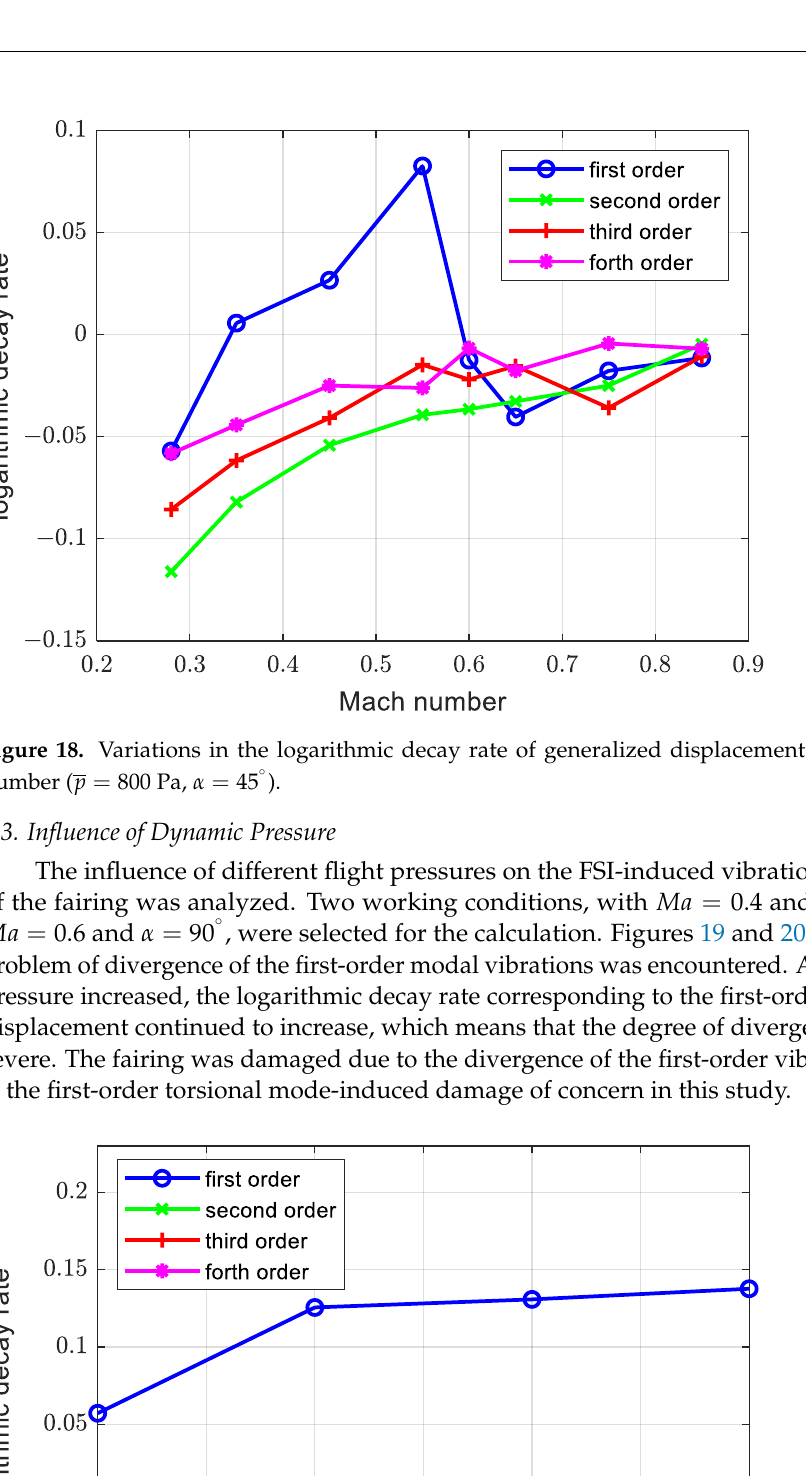
Figure 20. Variations in the logarithmic decay rate of generalized displacement with the dynamic pressure ( 0.6  Ma , 90  